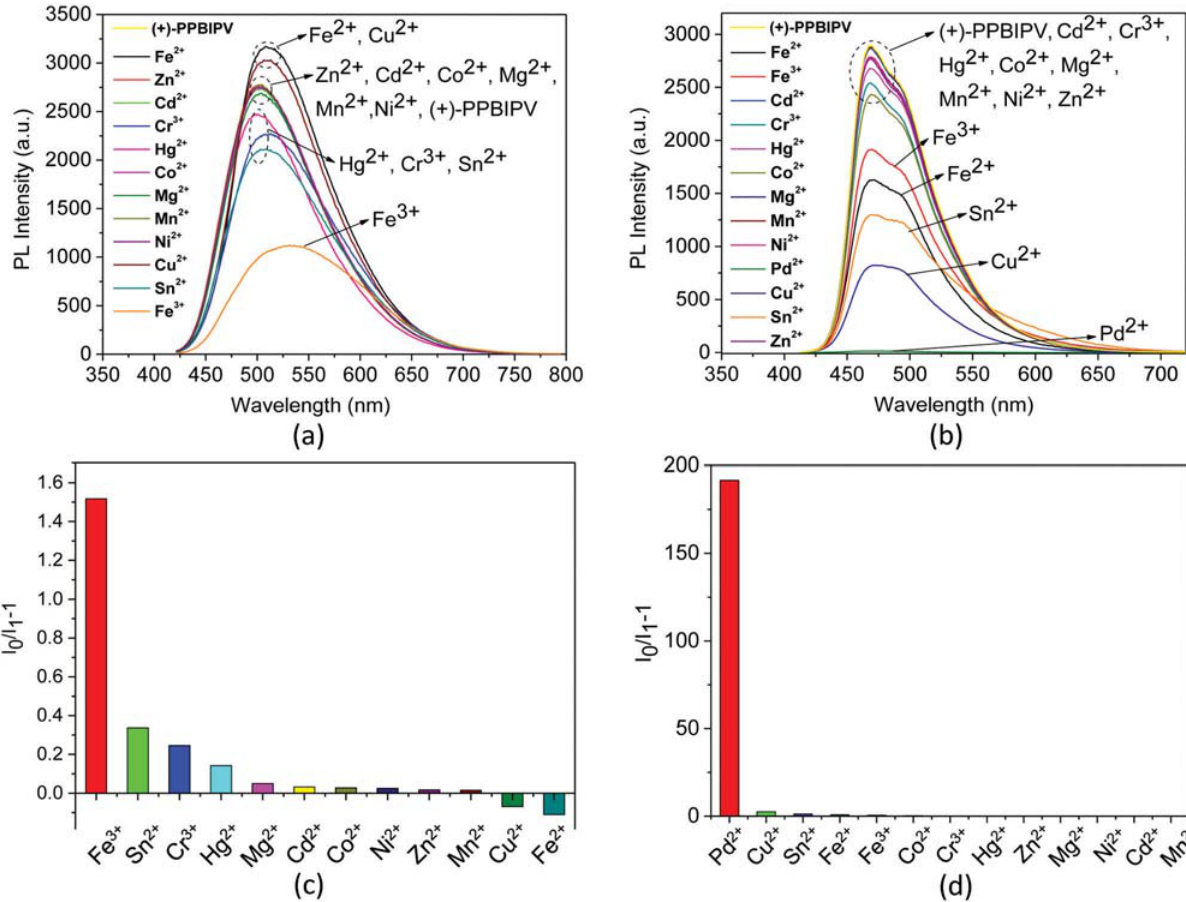
Figure 4: PL spectra of aqueous solution of (+)-PPBIPV with different metal ions (a); PL spectra of methanol solution of (+)-PPBIPV with different metal ions (b); PL quenching ratios (I ratios (I /I -1) of methanol solution of (+)-PPBIPV with different metal ions 0 1